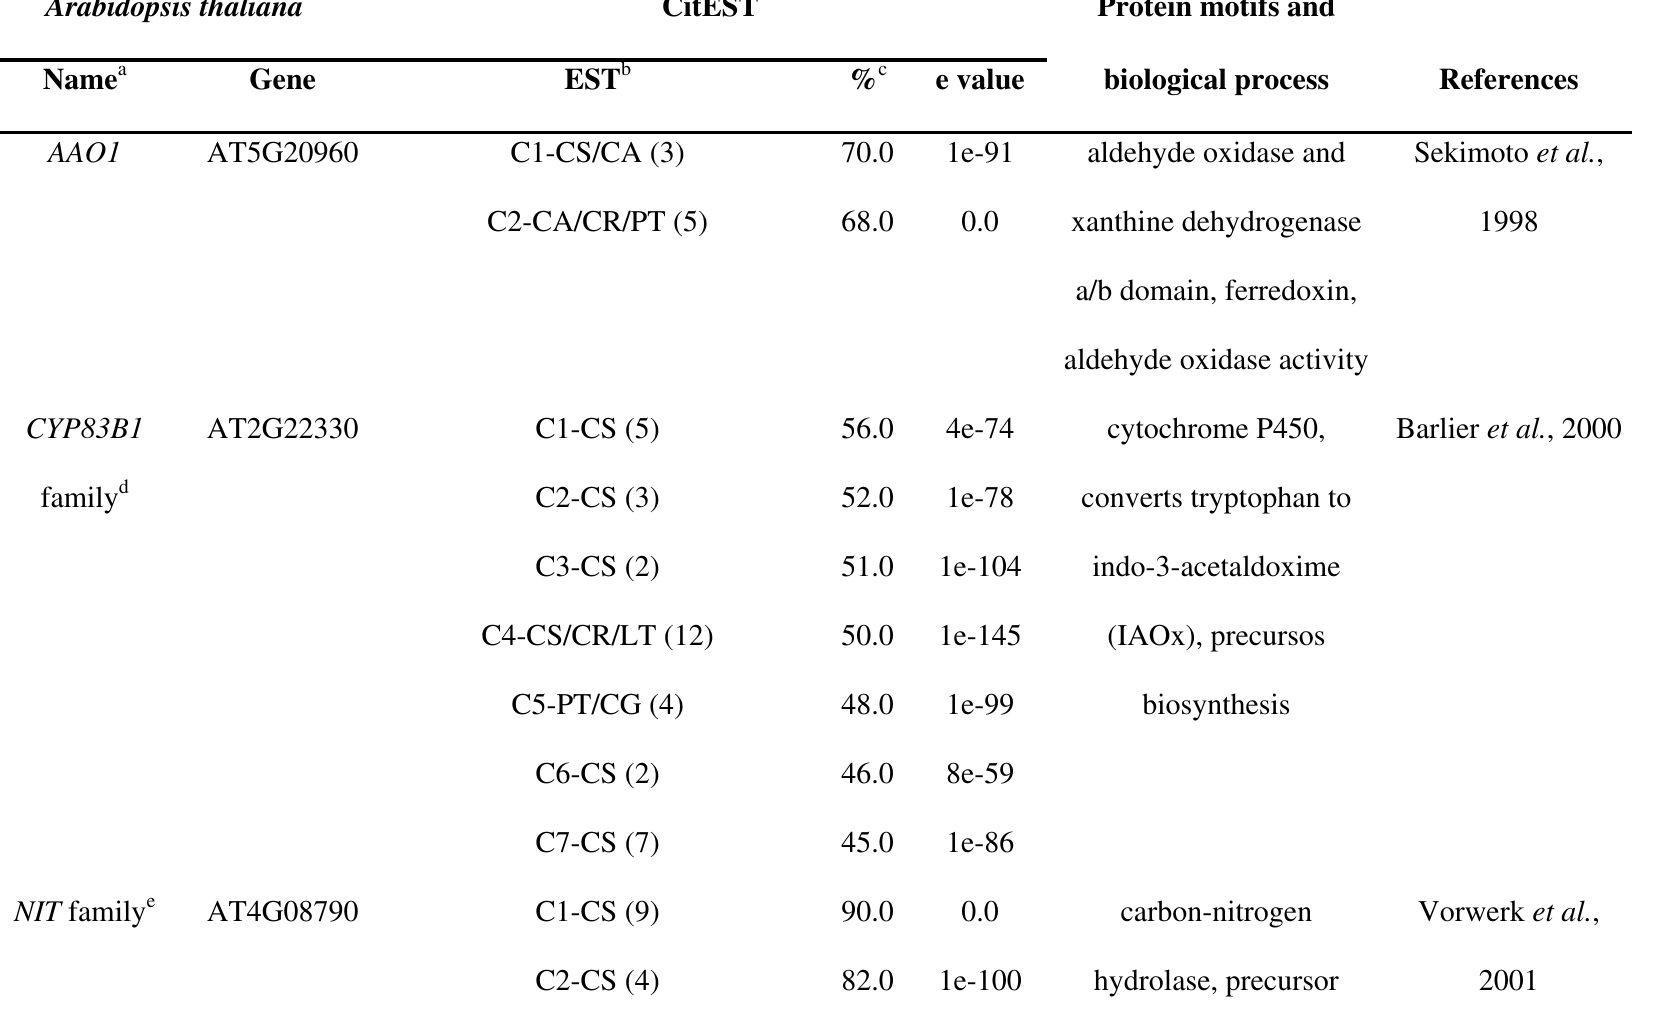
Table S2 – Citrus ESTs homologous to Arabidopsis and Oryza sativa functionally-characterized auxin metabolism genes. Arabidopsis